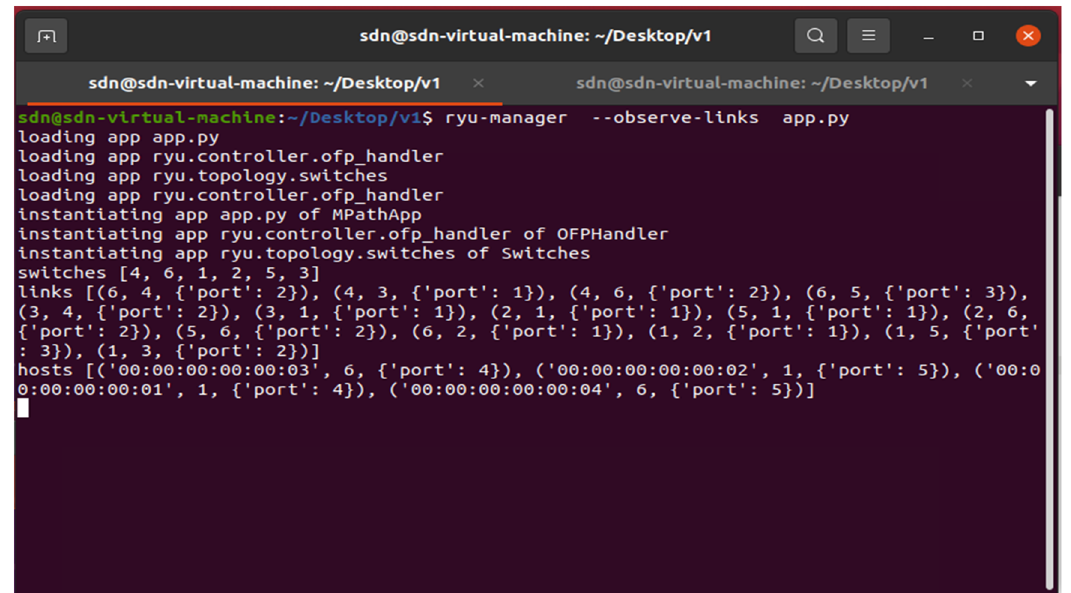
Figure 4: Running Ryu